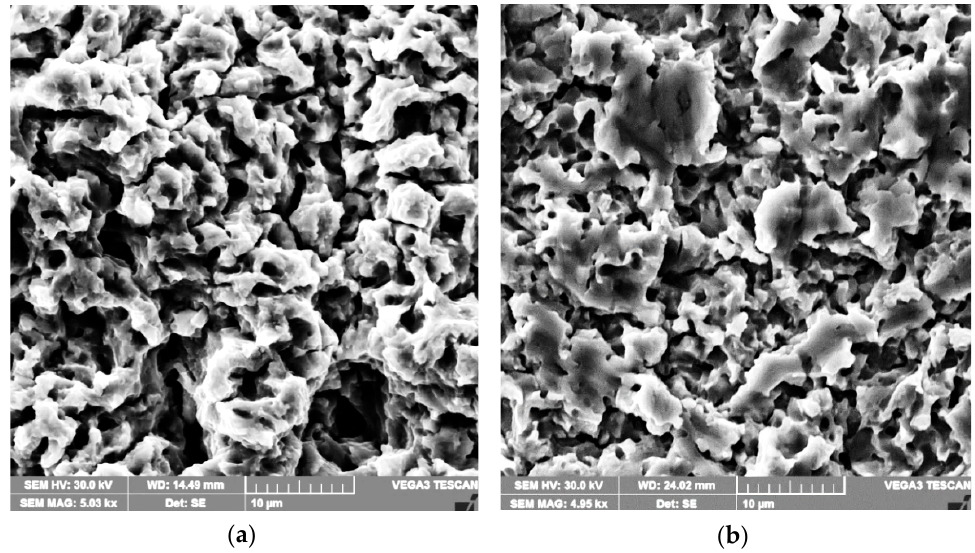
Figure 12. SEM image of the cavitation-eroded sample surfaces: ( a ) Solution treatment; ( b ) Solution treatment followed by nitriding